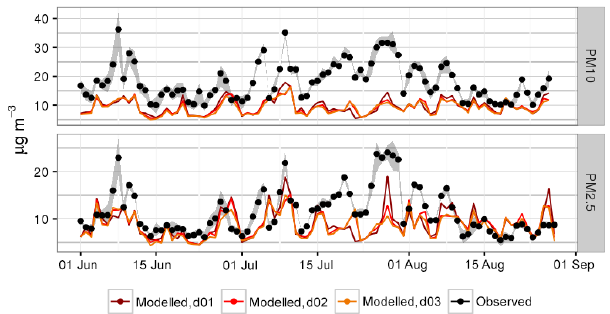
Figure 12. Daily mean PM 10 and PM 2 . 5 concentrations as observed and modelled (base run) at urban background stations in Berlin. Daily means are averaged over five stations for PM 10 and four sta- tions for PM 2 . 5 . The grey shaded areas represent the variability between the different stations, showing 25th and 75th percentiles. Model results are given for all three model domains (d01 – 15km horizontal resolution, d02 – 3km, d03 –